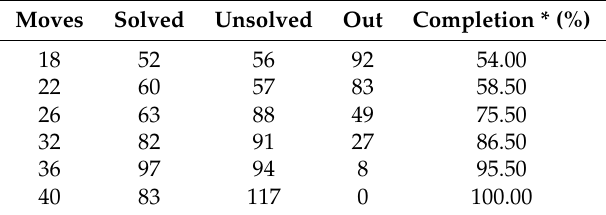
Table 3. Additional experiment result of applying PPNS to different stages of Othello